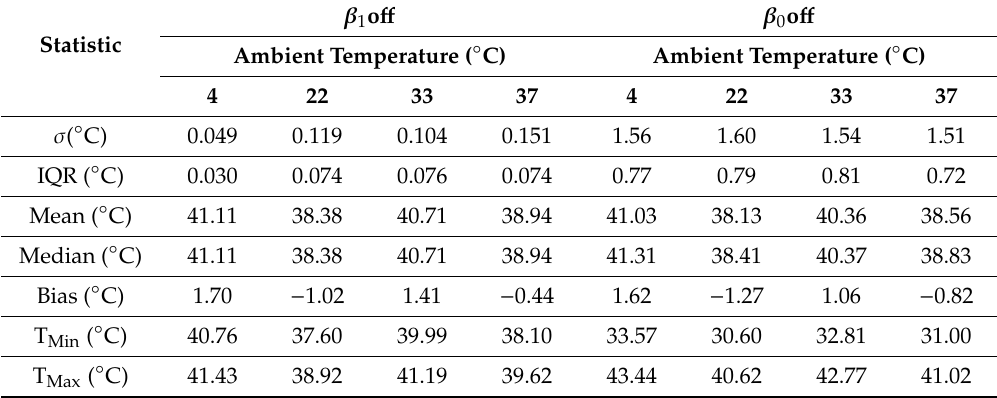
Table 2. Descriptive statistics to evaluate the impact of the β 1 and β 0 coe ffi cients in the vignetting of the TeAx 640 images. Having the β 0 coe ffi cient active produced images with no apparent vignette e ff ect and with lower standard deviation and interquartile range (IQR) under all evaluated ambient